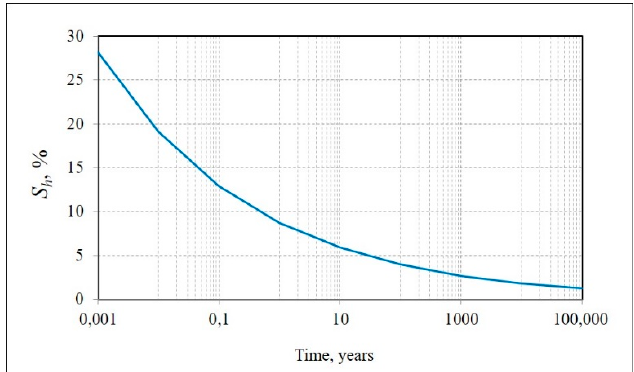
Figure 6. Predicted time-dependent decrease in hydrate saturation in frozen soil at T = − 6 °C and P = 0.1 MPa.